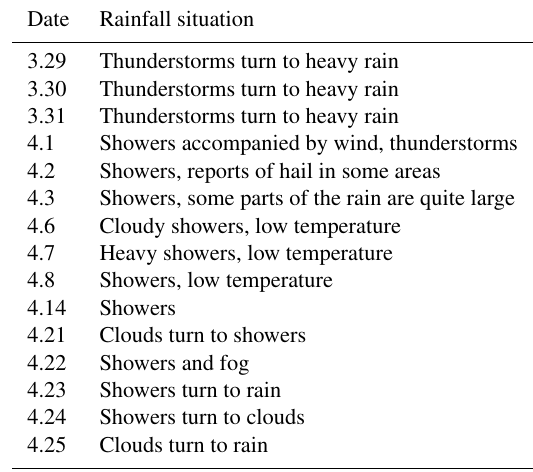
Figure 1. The GNSS stations (11 black rhombuses), the ra- diosonde station (one red star), and the ECMWF comparative points (12 ochre circles) in Hong Kong. The gridded lines indicate tomog- raphy grids. Table 1. Rainfall information for March and April